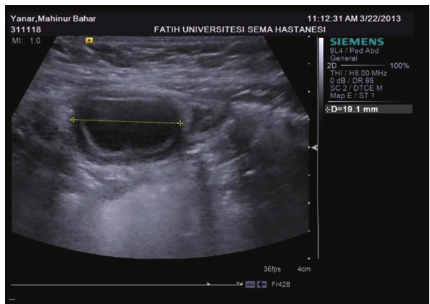
Figure 1: On sonography, we found that the hypoechoic outer wall of the cystic structure was continuous with the hypoechoic outer wall of the adjacent ileal bowel, and the hypoechoic outer wall of the cystic structure was continuous with the hypoechoic outer wall of the adjacent ileal bowel.